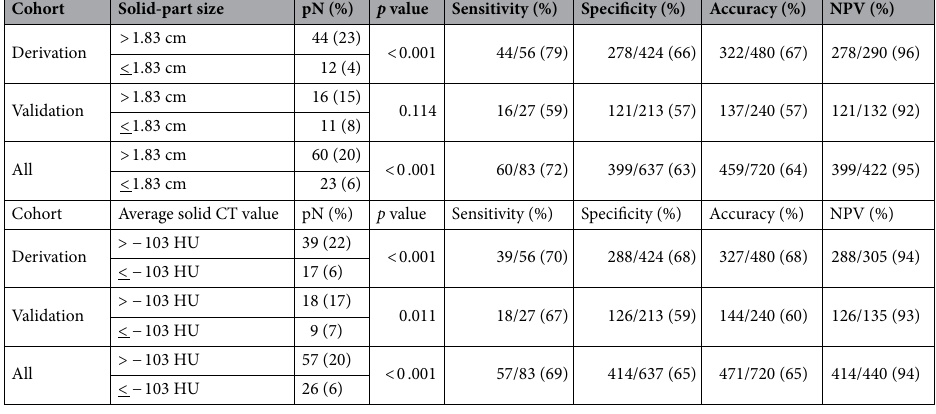
Table 3. Correlation between the significant values and lymph node metastasis. pN pathological lymph node metastasis; NPV negative predictive value; CT computed tomography; HU Hounsfield